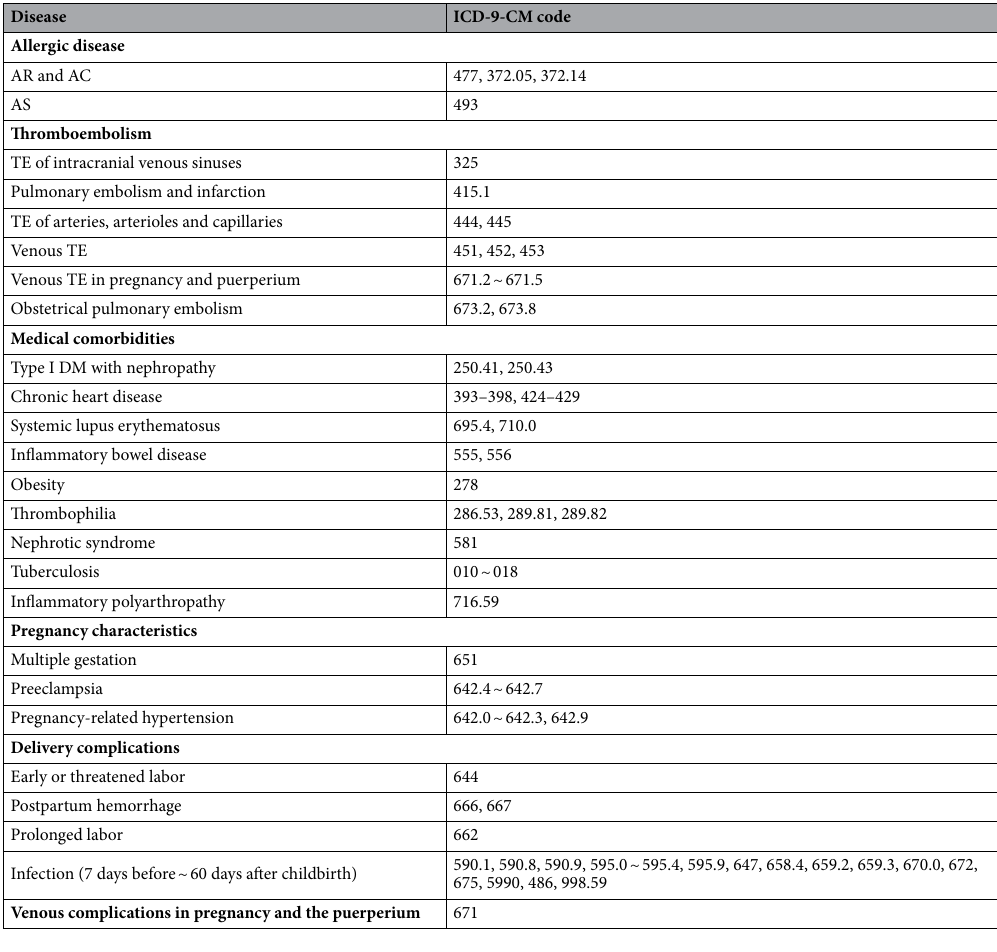
Table 1. ICD-9-CM codes used in the